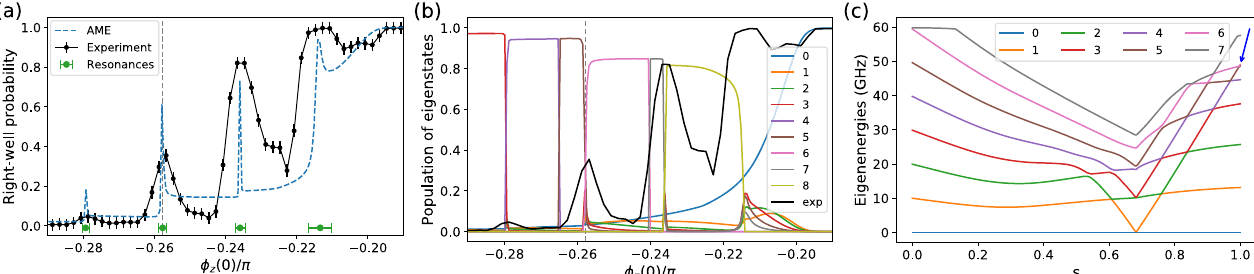
Fig. 5 Resonant features of a quantum multi-level structure of the CSFQ. a Persistent current readout giving the right-well probability as a function of the initial tilt bias, for a linear anneal in both φ x and φ z , as illustrated by the slanted arrows in Fig. 3. Tilt bias anneal amplitude is amp = 0.326 π , i.e., φ z ( t ) = φ z (0) + amp × ( t / t f ), where t f = 60 ns is the anneal time. The black solid line shows the experimental result, and the dashed blue line is the AME result for the CSFQ circuit with parameters extracted from spectroscopy (see text). Experimental error bars show standard deviation and are calculated as in Fig. 4. b Population of CSFQ circuit eigenstates (indicated by the numbers in the legend, with 0 being the ground state) at the end of each annealing, along with the experimental result (exp) also shown in ( a ). Only avoided level crossings lead to observable features in the persistent-current readout, indicated by the green circles in ( a ). c An example of the CSFQ spectrum vs normalized anneal time s = t / t f , for an initial tilt bias corresponding to the gray vertical dashed line in panels ( a ) and ( b ). The blue arrow marks the avoided level crossing between levels 5 and 6 at the end of the anneal, which corresponds to the population exchange between these two levels in panel ( b ), and the corresponding experimental resonant feature. Cascaded level crossings that transfer the population are visible throughout the